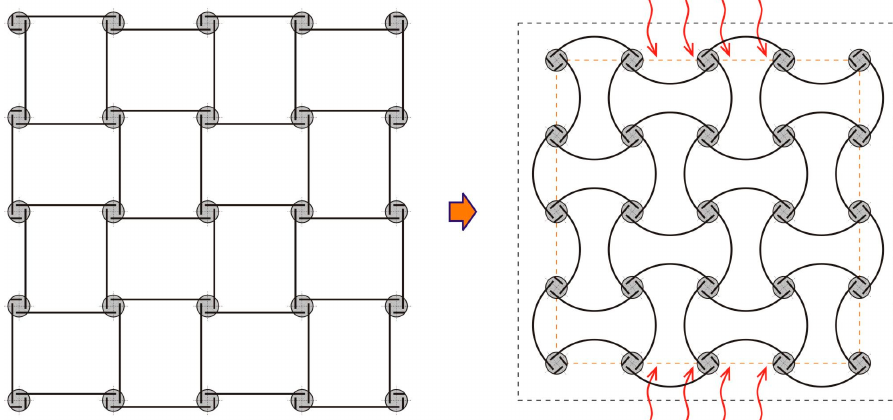
Figure 1. Antichiral metamaterial architecture, enabling negative (effective) thermal expansion. Continuous elastic thermal buckling of the bimetal strips, shown as solid lines, leads to an overall contraction of the material sample with temperature.